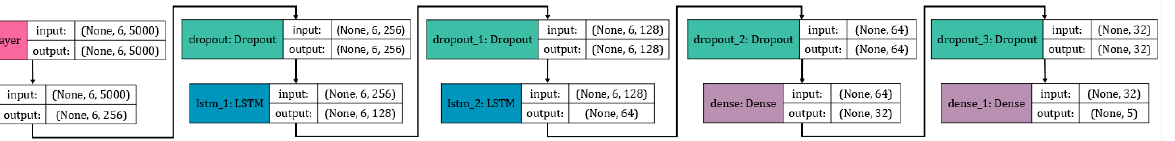
Figure 6. LSTM network architecture and parameters at each